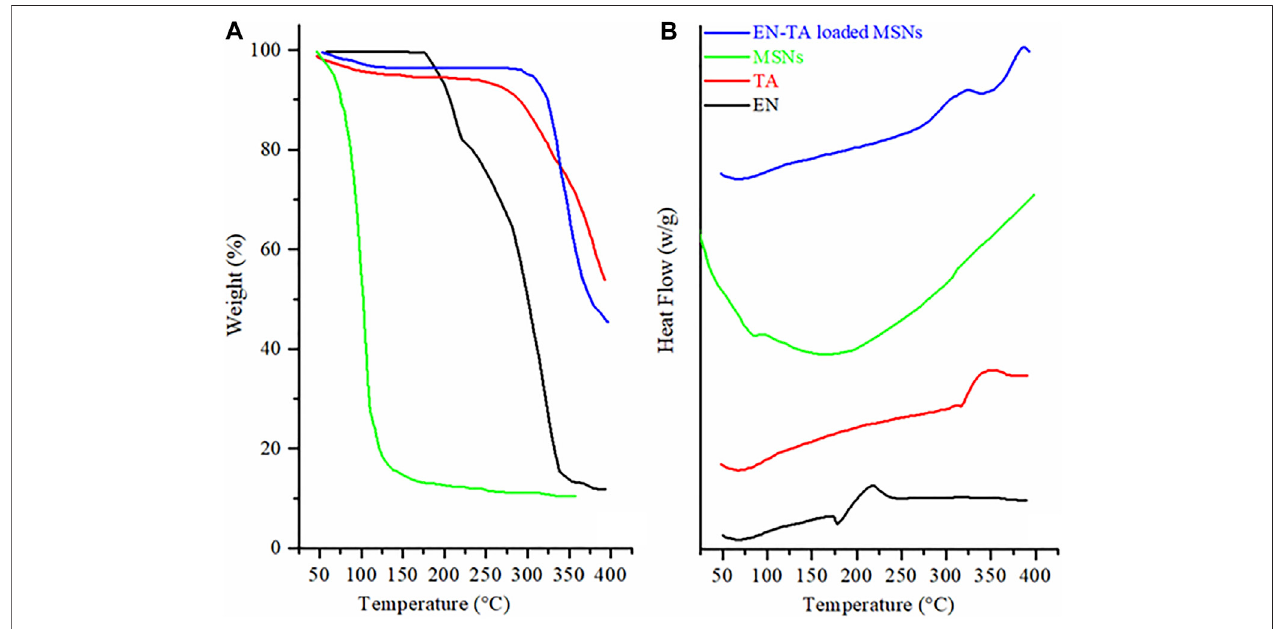
FIGURE 3 | (A) TGA and (B) DSC thermograms of econazole nitrate (EN), triamcinolone acetonide (TA), MSNs, and EN-TA loaded